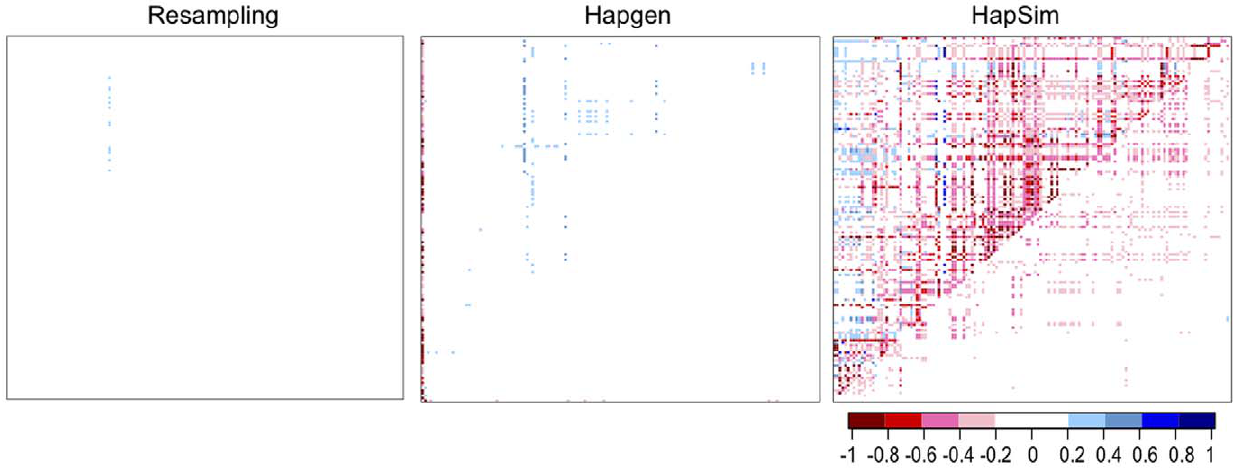
Figure 4. Heat maps of change in median LD for Gene Region 1. Heat maps of change in median simulated LD from original LD in Gene Region 1 (median[LD simulated ] – LD HapMap ). Upper left D’, lower right r 2 . Blue indicates a gain in LD; red indicates a loss in LD.